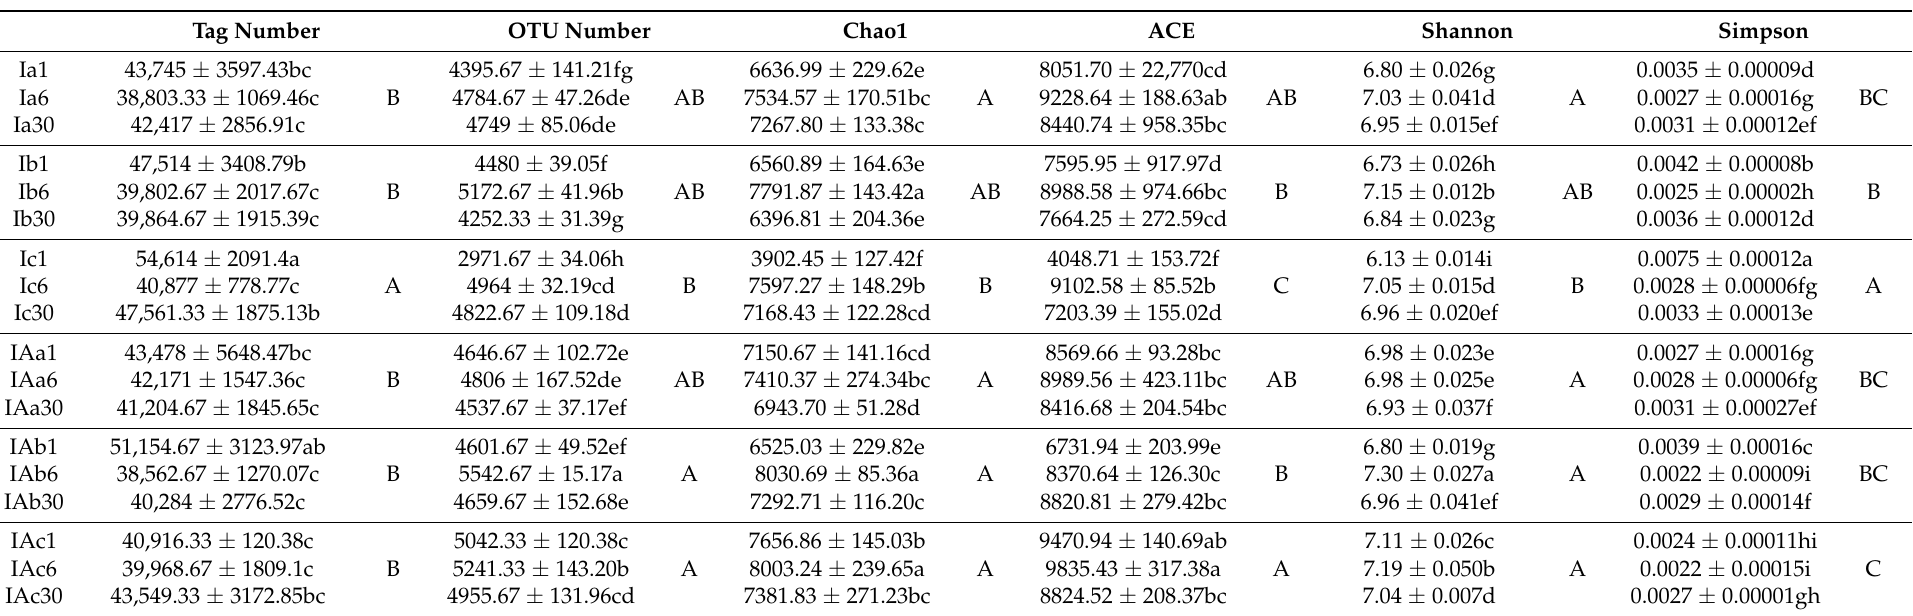
Table 3. Analysis of the microbial diversity indices of the soil